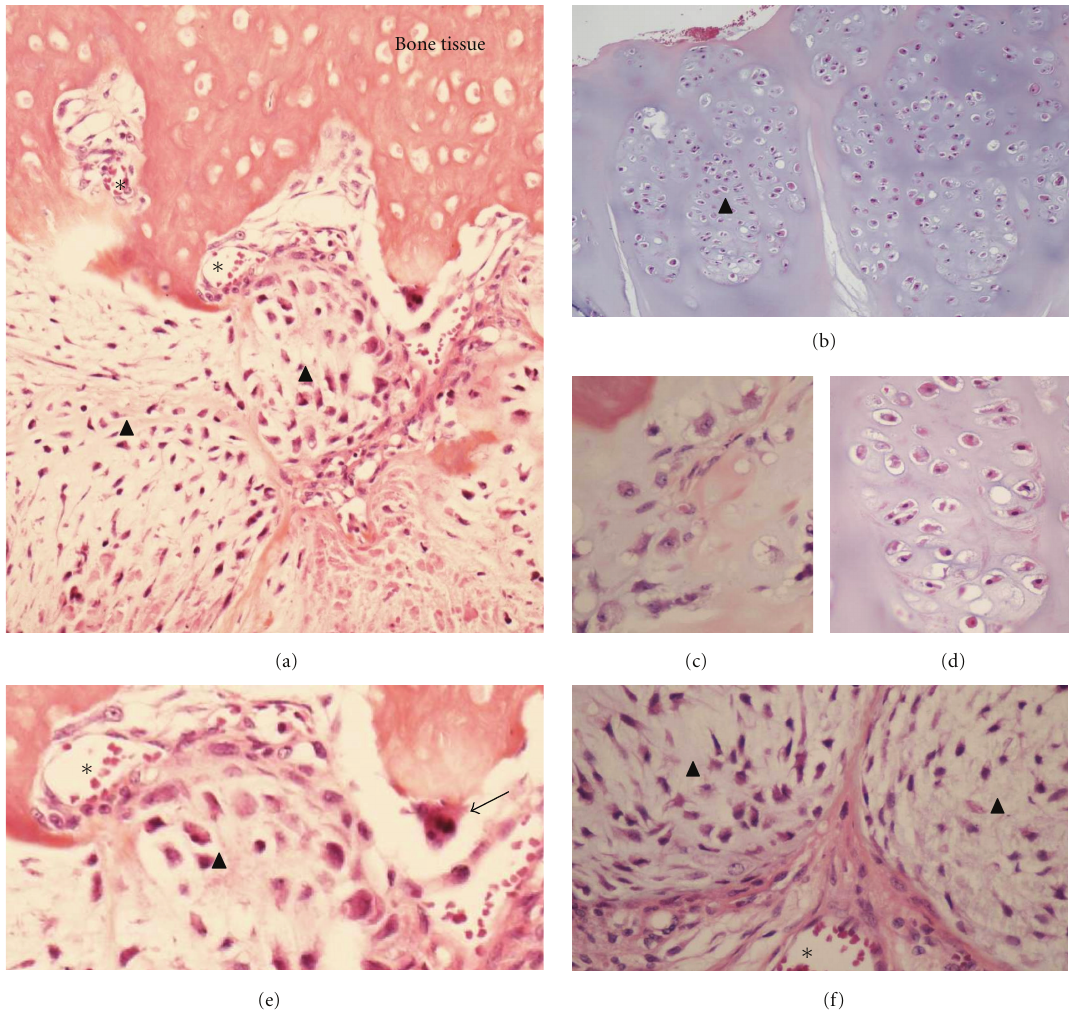
Figure 1: The bone niche of chondrosarcoma is composed by various cellular entities. Chondrosarcoma tissue shows heterogeneous cell morphology (a–d) with chondrocyte-like (b–d) and mesenchymal features (f). Chondrosarcoma bone niche is associated with several cell types including osteoclasts (e), endothelial cells vascularized soft tissue (f). HES staining, original magnification ( × 20, a and b; × 40: c–e). Tumour cells: arrow head, asterix: blood vessels, and arrow: